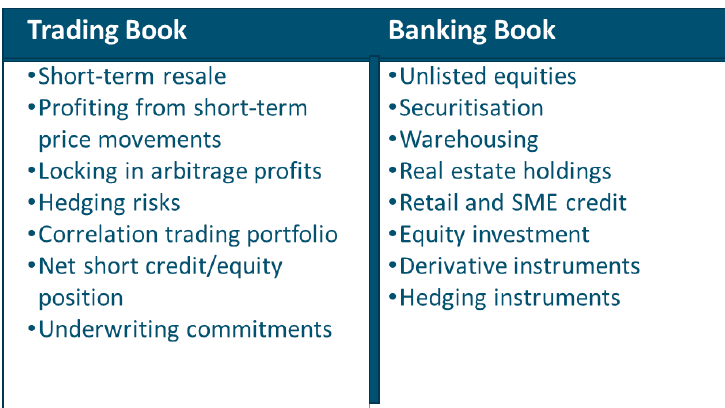
Table 3. Overview of the trading and banking book.